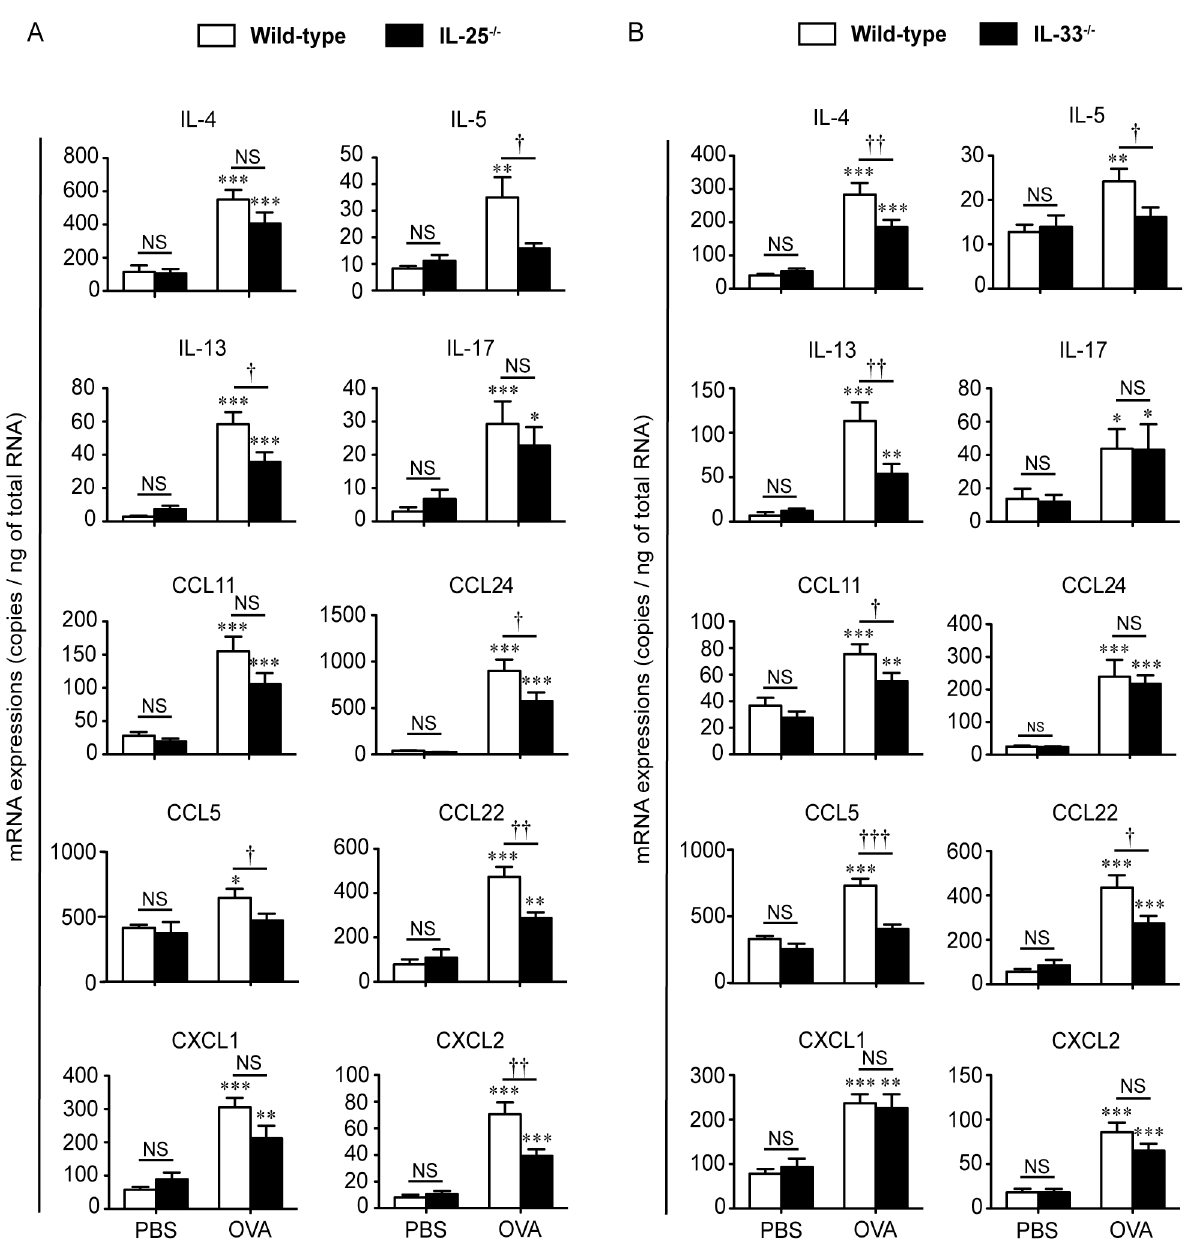
Fig 5. IL-25 and IL-33 are important for expression of Th2-type/associated cytokines and chemokines, but not Th17-type cytokines, after the last intranasal OVA challenge, in lungs from mice sensitized epicutaneously (EC) with OVA. Total mRNA was isolated from the lungs of wild-type (WT), IL- 25 -/- mice and IL-33 -/- mice as shown in Fig 2E. The expression of mRNA for cytokines and chemokines was determined by quantitative PCR. (A) WT (PBS, n = 8; OVA, n = 24) and IL-25 -/- mice (PBS, n = 8; OVA, n = 28). (B) WT (PBS, n = 10; OVA, n = 20) and IL-33 -/- mice (PBS, n = 11; OVA, n = 20). Data are pooled from three independent experiments, each of which gave similar results. Data show the mean + SEM. * P < 0.05, ** P < 0.01 and *** P < 0.001 vs. the corresponding values for PBS-treated mice. † P < 0.05, †† P < 0.01 and NS (not significant) vs. the indicated group (WT vs. IL-25 -/- , or WT vs. IL-33 -/-